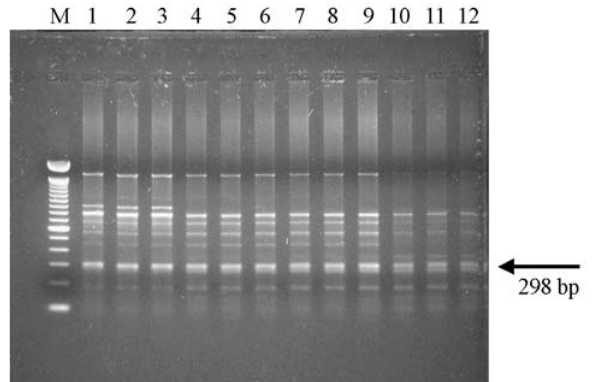
Figure 6 - Low-stringency amplicons separated by 1.5% agarose gel elec- trophoresis Lane M: 100-bp DNA molecular weight markers; Lanes 1-3: PCR products using 1.5 mM MgCl 2 ; Lanes 4-6: PCR products using 2.0 mM MgCl 2 ; Lanes 7-9: PCR products using 2.5 mM MgCl 2 ; Lanes 10-12: PCR products using 3.0 mM MgCl 2 . The 298-bp band (arrow) was used as competitor template.